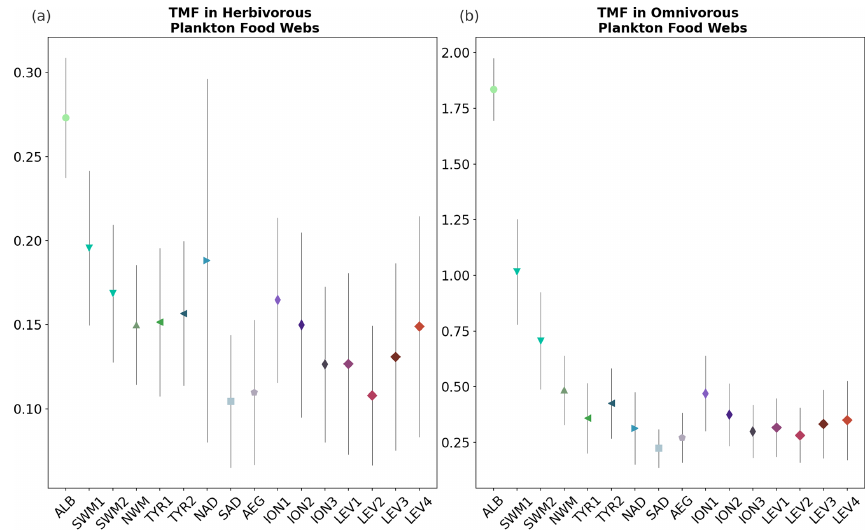
Figure 9. Trophic magnification factor (TMF, unitless) for the (a) omnivorous and (b) carnivorous plankton food webs (Fig. 8) for each subbasin of the Mediterranean Sea (Fig. 1), calculated by integrating over 0–100m depth the monthly outputs of the OGSTM–BFM–Hg